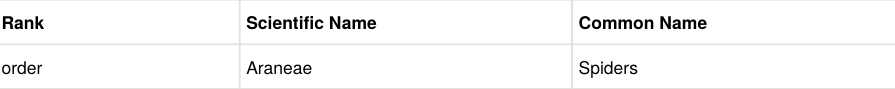
Study dates : Samples were collected in June 2016, with all but pitfall trapping being conducted on the 13th and 14th. Pitfall traps were left in the fi eld between the 13th and 26th of June 2016. Sampling description: The COBRA - Conservation Oriented Biodiversity Rapid Assessment - protocol at the four plots was followed. This protocol, fi rst proposed for Mediterranean spiders (Cardoso 2009) and very recently adapted for and being applied both on the tropics (Malumbres-Olarte et al. 2016) and islands (Emerson et al. 2017) involves night aerial sampling (4 hours/plot), day/night sweeping (4 hours/plot), day/night beating (4 hours/plot) and pitfall traps (48 traps distributed for 12 samples). In total, it involves about 24 hours of e ff ective work per site (see Cardoso 2009 for details).